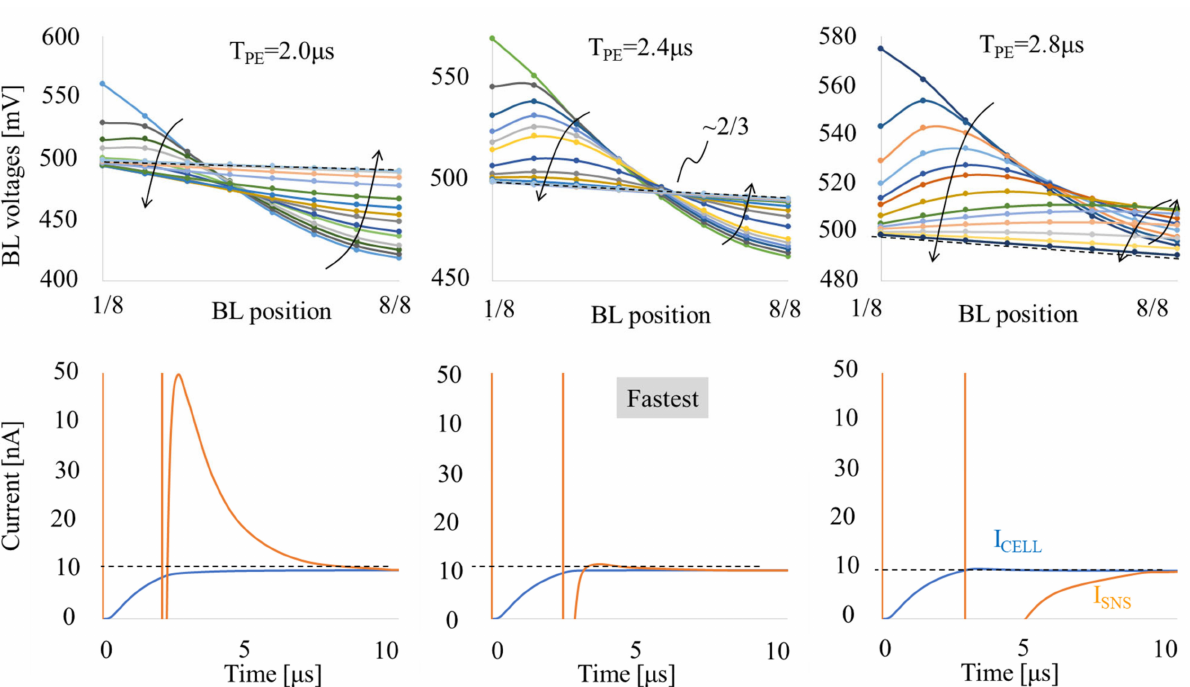
Figure 7. BL voltage ( upper ) and current waveform ( lower ) with different Tpre (2.0 µ s, 2.4 µ s and 2.8 µ s from left to right, respectively) values when the “1” cell at x = 100% is selected.